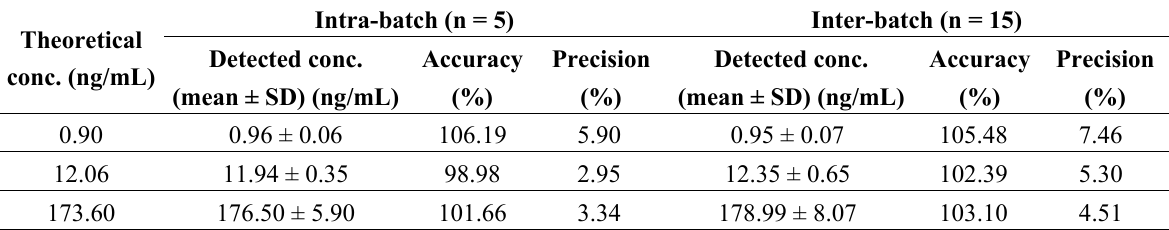
Table 1. Intra- and inter-day precision and accuracy for LC-MS/MS assay of ATRA in human